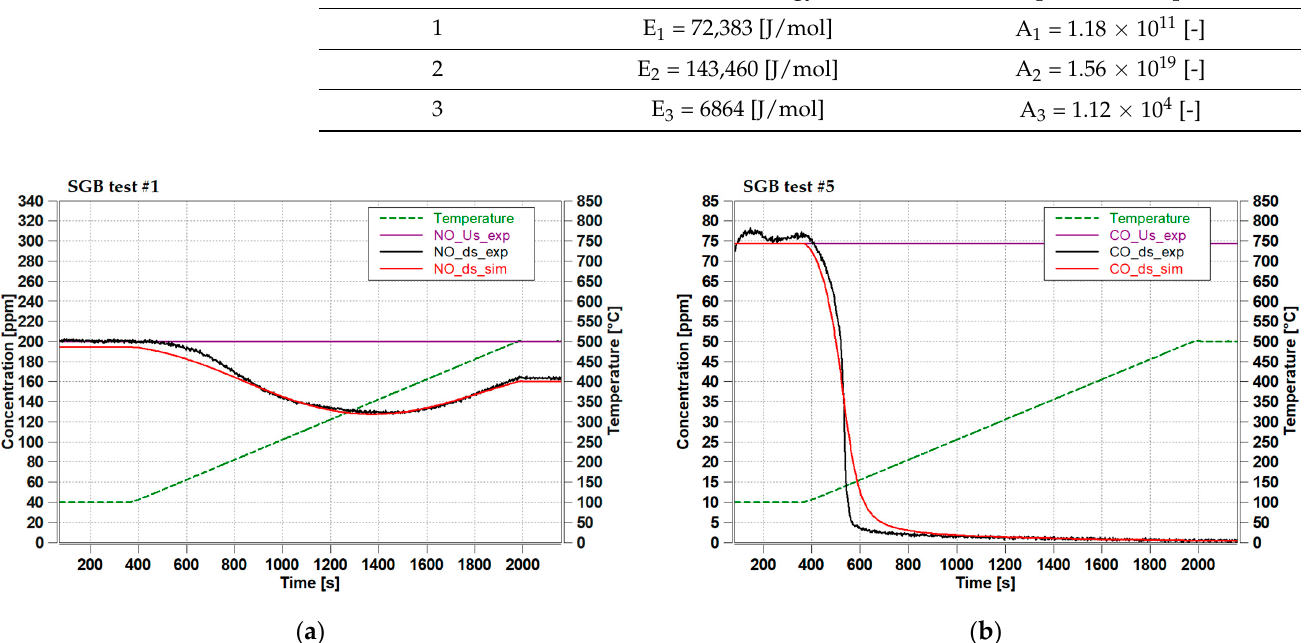
Figure 10. ( a ) Simulated (red) vs. experimental (black) NO x emission downstream DOC. ( b ) Simu- lated (red) vs. experimental (black) HC emission downstream DOC.